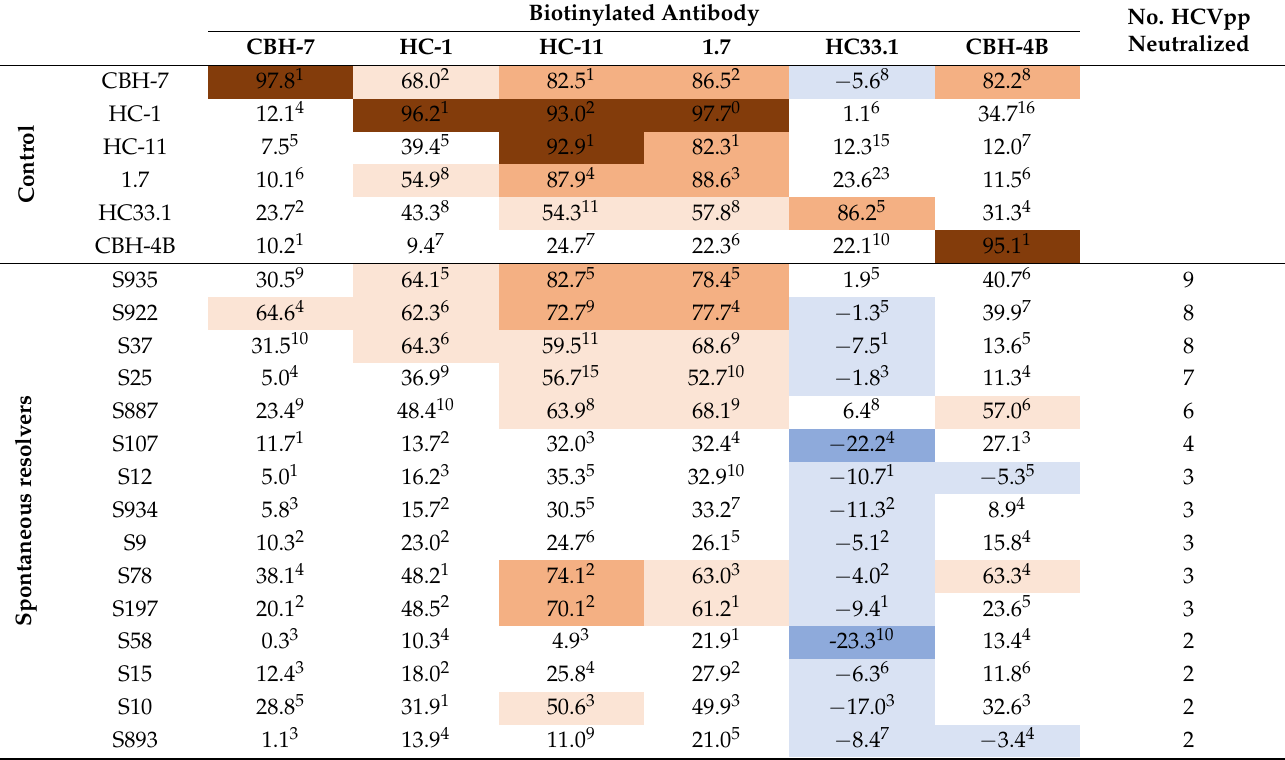
Table 5. Cross-competition analysis with neutralizing mAbs. Biotinylated Antibody No.